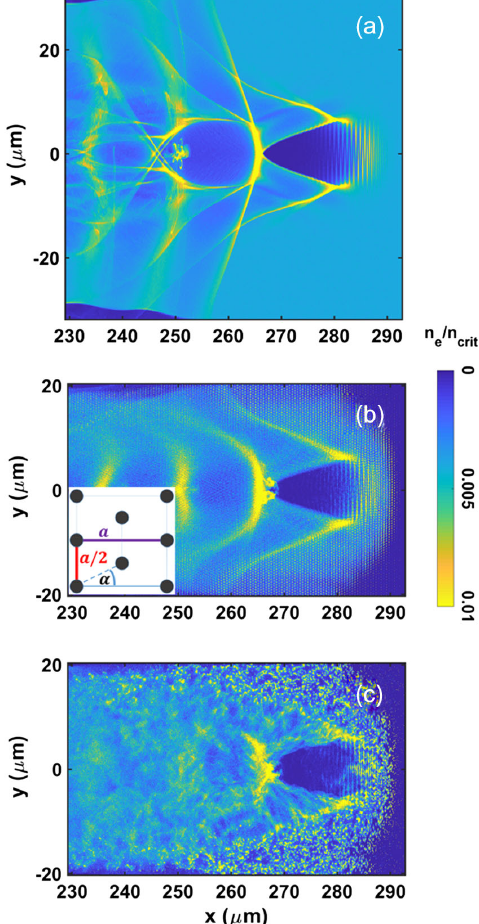
FIG. 1. Results of PIC simulations A, B, and C (parameters according to Table I). Electron density normalized to critical density for (a) a uniform plasma, (b) a plasma of clusters arranged in a staggered grid, and (c) a plasma of clusters with random positions after